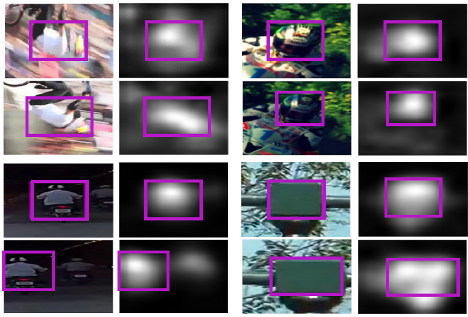
Figure 5. The heat map for prediction. In each sub four-images, the left top is the target image with ground truth to generate the heat map and calculate the target concept also the initial score of the concept (top left). The lower left image is the search image, and the right bottom image is the heat map generated by the concept from the target image. The ground true in search image is used to calculate the predict